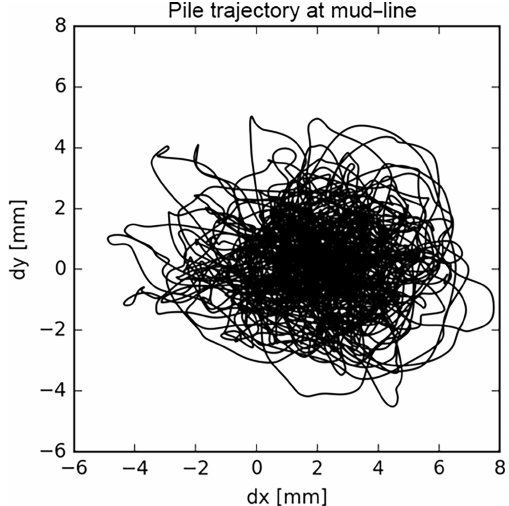
Figure 25. Pile trajectory at mud-line for load case 15.